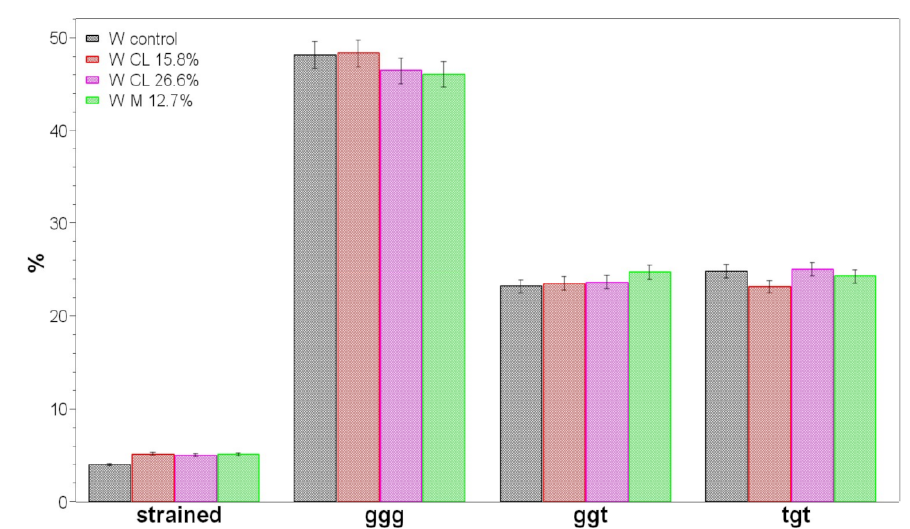
Figure 12. Results of the curve fitting procedure on the 580–480 cm − 1 Raman spectral region displaying the main conformations adopted by disulfide bridges (SS), i.e., strained, gauche-gauche- gauche (ggg), gauche-gauche-trans (ggt) and trans-gauche-trans (tgt). A standard error of 5% was used for error bars